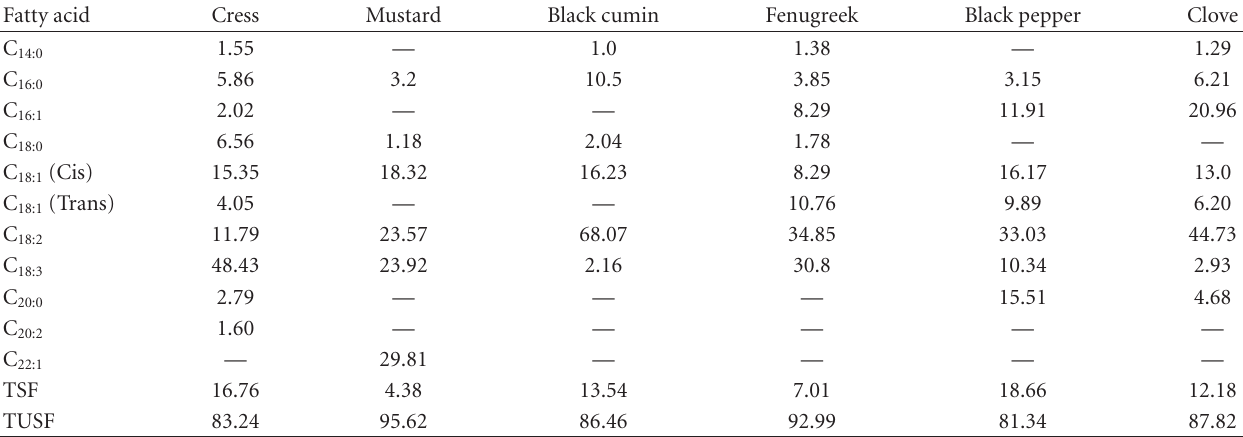
Table 3: Fatty acid (%) extracted from cress, mustard, black cumin, fenugreek, black pepper, and clove seeds ∗ . Fatty acid Cress Mustard Black cumin Fenugreek Black pepper